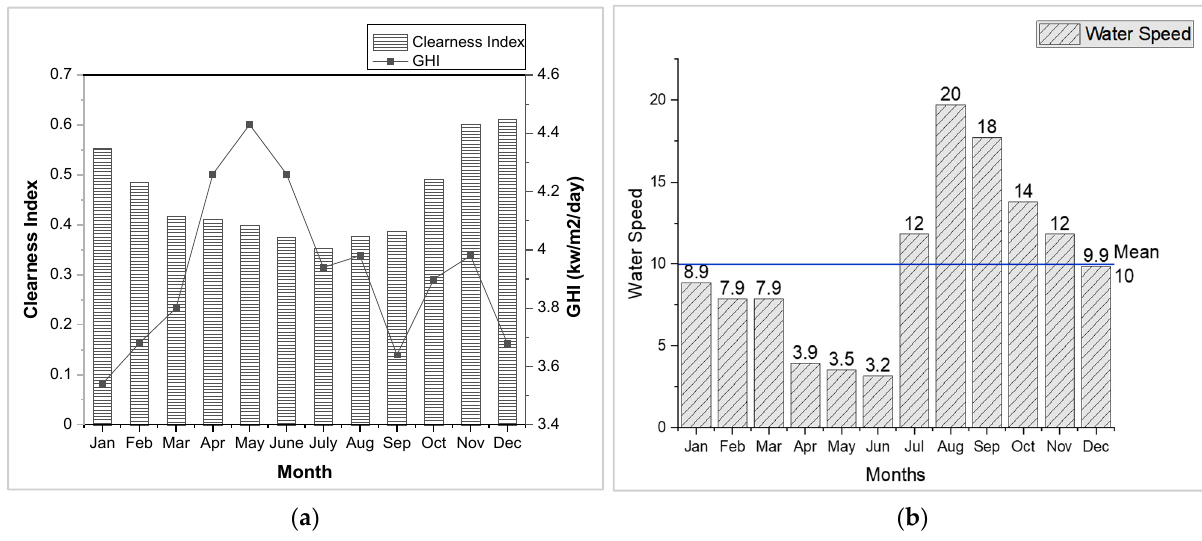
Figure 2. ( a ) Global horizontal index and clearness index of solar photovoltaics. ( b ) Monthly average streamflow of the river. Year: 2018, Location: Nazira (27°1.8 ′ N, 94°52.4 ′ E).